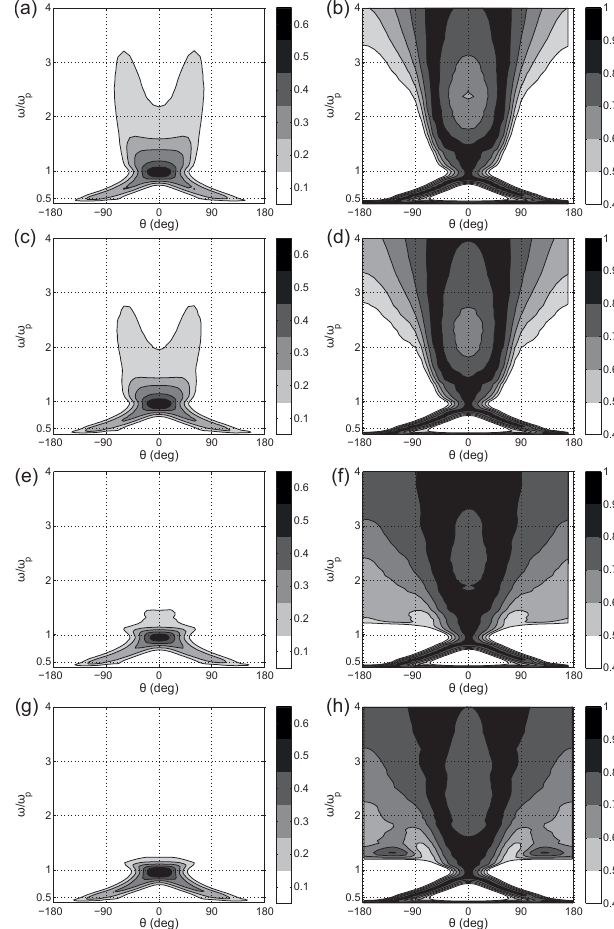
Figure 7. Isolines of spreading functions for different runs (see Ta- ble 1): (a, b) sw030; (c, d) sw170; (e, f) sw330; (g, h) run sw330 with finer resolution at angle (cid:49)θ = 5 ◦ . Left column – definition (Eq. 32); right – directional distribution (Eq.